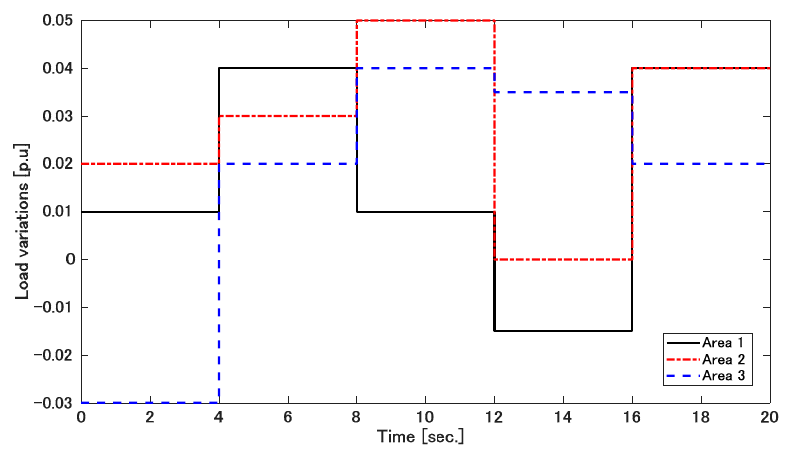
Figure 18. Load variations.